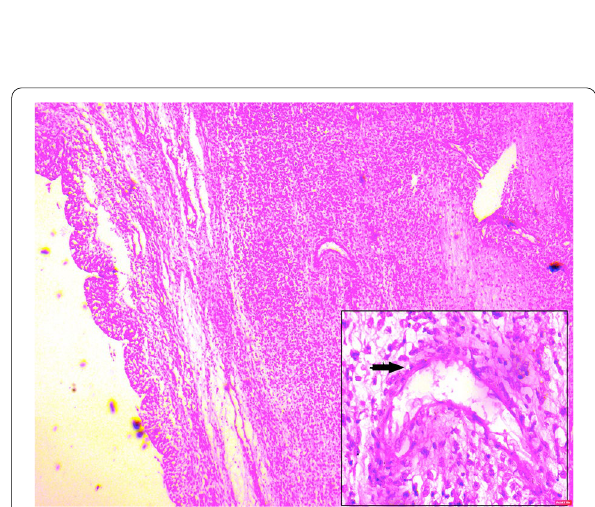
Fig. 3 Histology of the tumor showing monotonous looking stromal cells arranged in a hypercellular fascicular architecture in a hemangiopericytic fashion (H and E arrangement of tumor cells around a blood vessel in hemangiopericytic pattern (arrow) (H and E